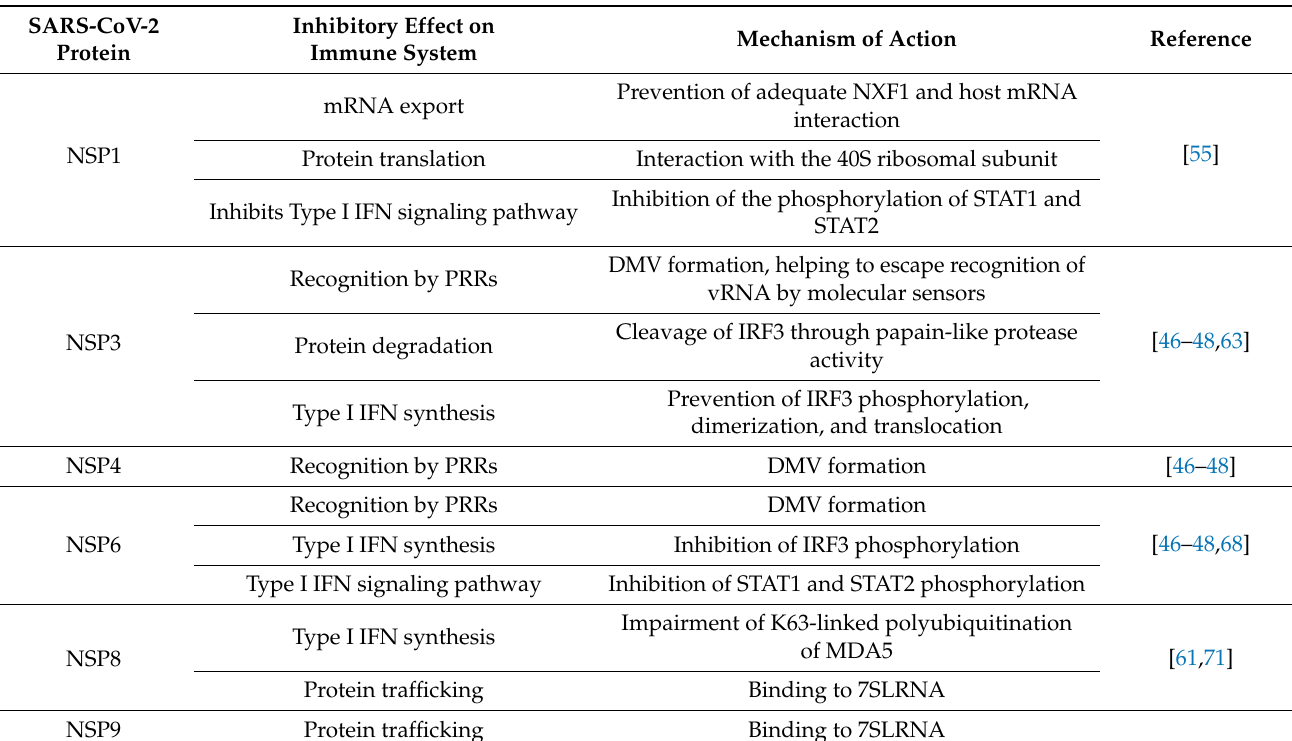
Table 1. Mechanism by which CoV proteins evade recognition by innate immune sensors and inhibit INF production and signaling